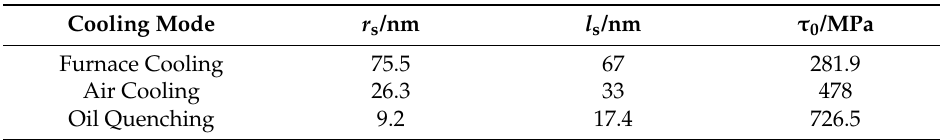
Table 2. Threshold shear stress for Orowan looping.